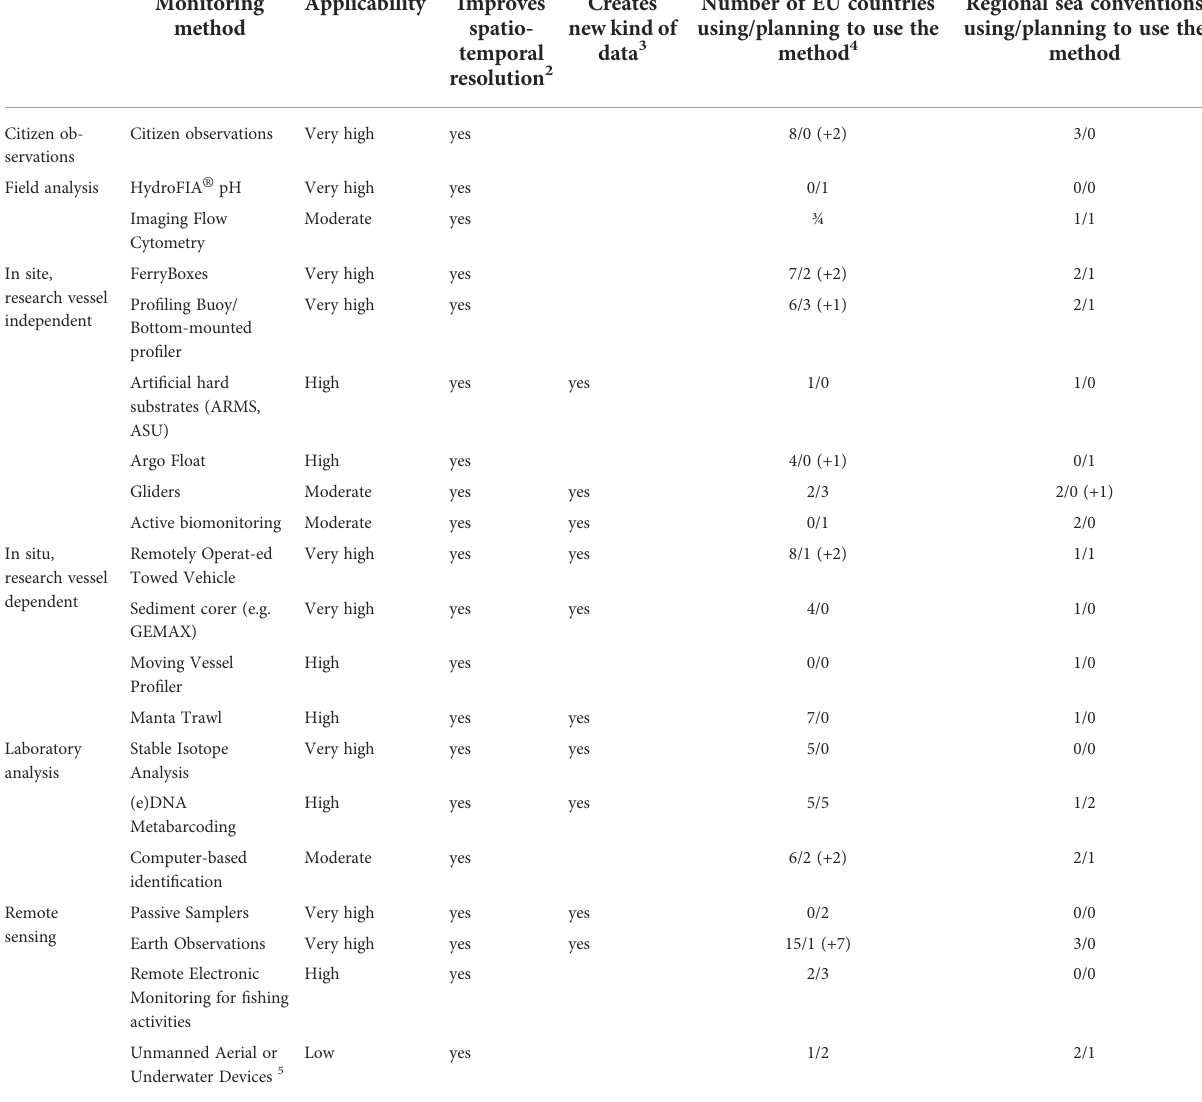
TABLE 1 A summary of the applicability of new methods and the use in current and planned monitoring in EU coastal member states and the regional sea